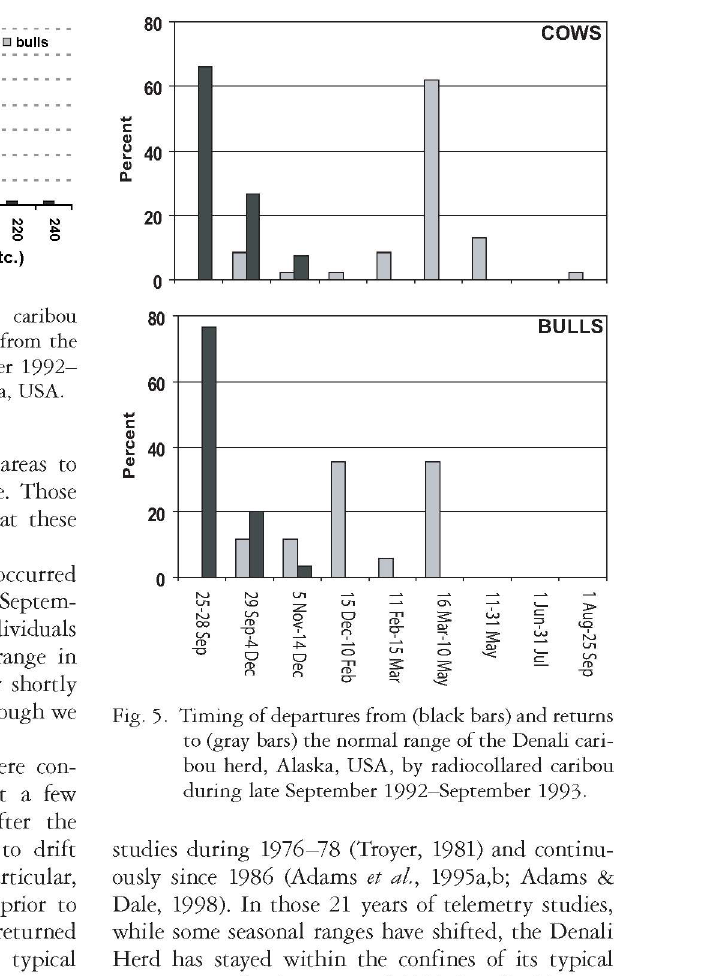
Fig. 4. Maximum distances that radiocollared caribou (» = 53 cows and 30 bulls) were located from the typical herd range during late September 1992— March 1993, Denali caribou herd, Alaska, USA.